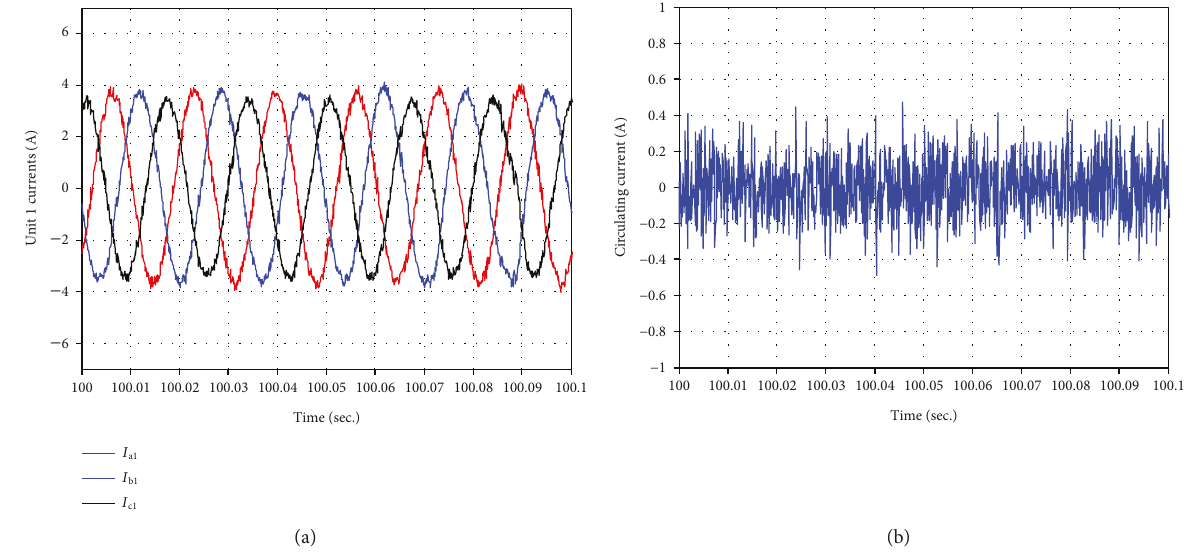
Figure 28: (a) The current inside unit 1 of con fi guration C. (b) The circulating current inside con fi guration C. Table 4: THD experimental comparison.